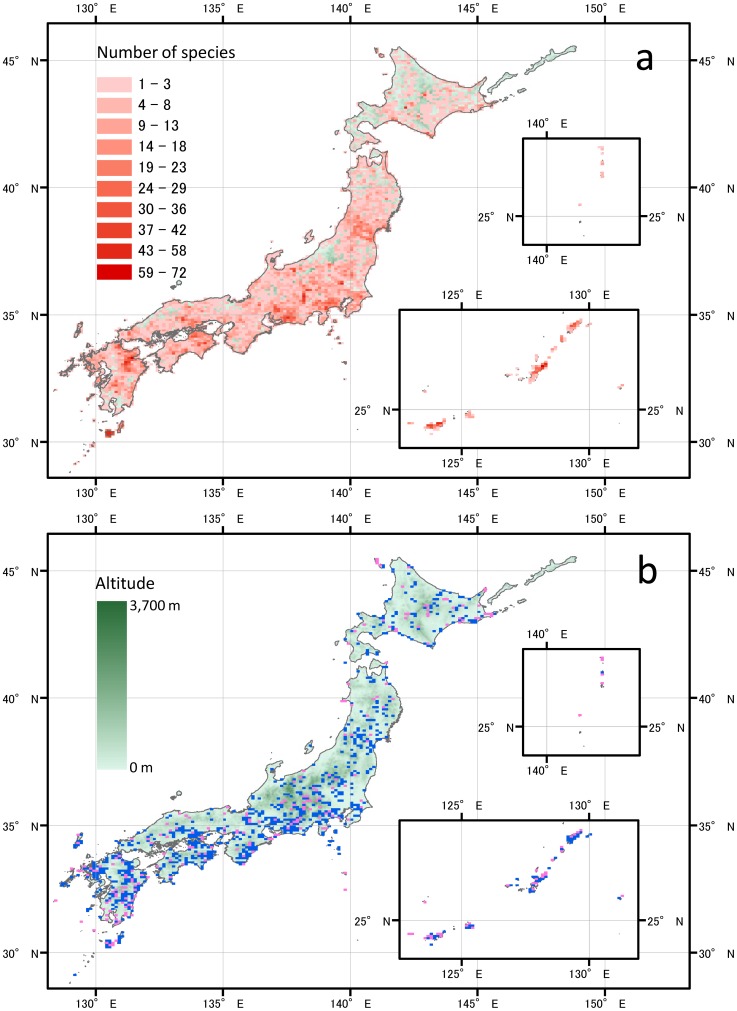
Distribution of 1618 vascular plant species in 4473 terrestrial cells (ca. 100 km2) in Japan, a and conservation prioritized cells, b.(a) One or more species were recorded in 3574 cells (79.9% of Japan). Green points represent the altitude of cells where no species were recorded with the same scale as in b. (b) Blue points represent 760 prioritized cells corresponding to 17% of the land area under the assumption that conservation effectiveness is 0.5 (see Fig. 2 and methods for details). Pink points represent 244 cells in which conservation effectiveness needs to be increased to conserve all threatened species; 237 of these are already included in the 760 prioritized cells. The maps were drawn using the ArcGIS 10.1 software (ESRI, Redlands, CA, USA).